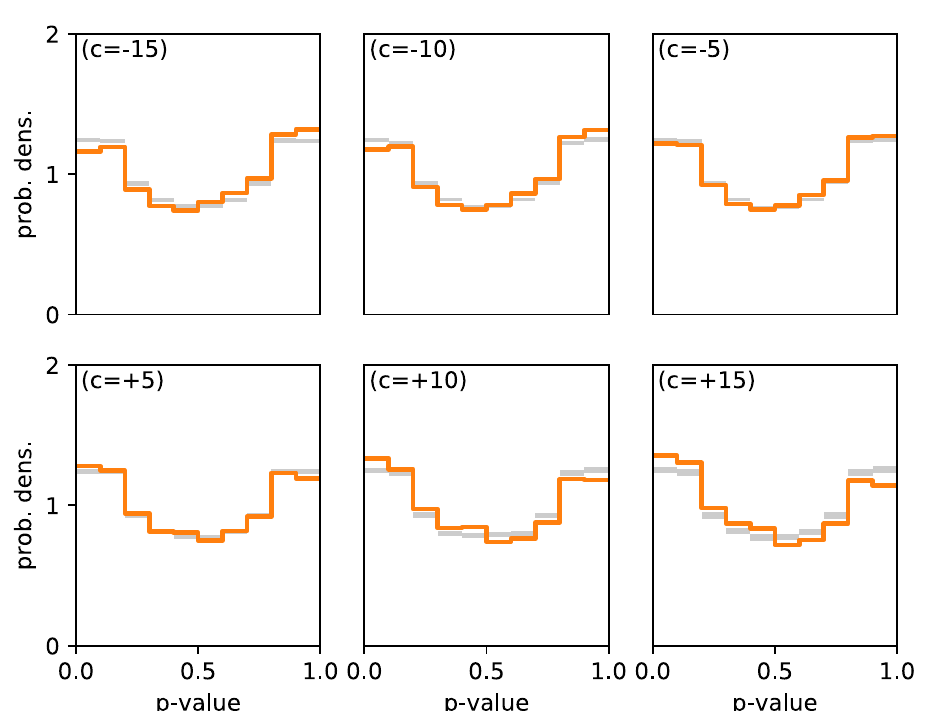
Figure 4. Application of the p value method to simulated data (modified SGS model), where tumor cells are for the immune cells weakly repulsive (top row, negative values of the chemotaxis response coefficient c ), or weakly attractive (bottom row, positive values of the chemotaxis response coefficient c ). Note that in the standard SGS model (Fig. 2d), the coefficient is c = + 500. For repulsive interactions, there are fewer small p values and more large p values than in the reference